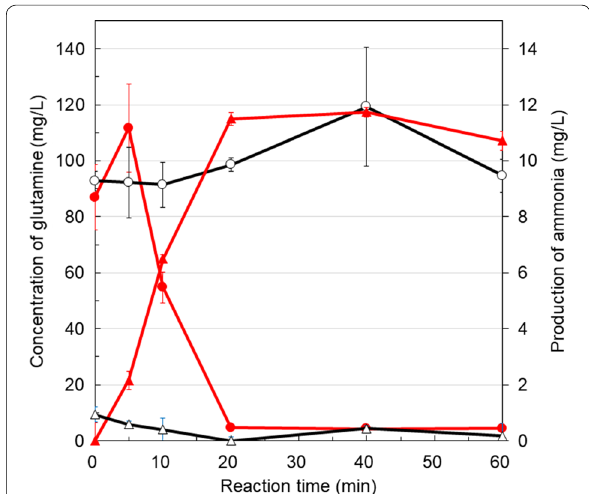
Fig. 4 Ammonia production from pretreated soybean residues by YbaS-displaying yeast. The amount of ammonia produced by YbaS-displaying yeast (pULD1-YbaS, red triangle) and control yeast (pULD1-s, open black triangle), and the residual glutamine by YbaS-displaying yeast (pULD1-YbaS, red circle) and control yeast (pULD1-s, open black circle) were measured. Values are given as mean SE (n ± =